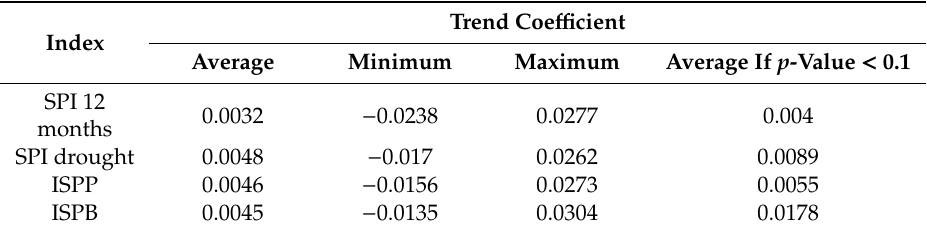
Table 2. Statistical values of the trend coe ffi cients calculated from the time-series (1952–2016) of the four indices (standardized precipitation index (SPI) 12 months, SPI drought, ISPP, and ISPB).